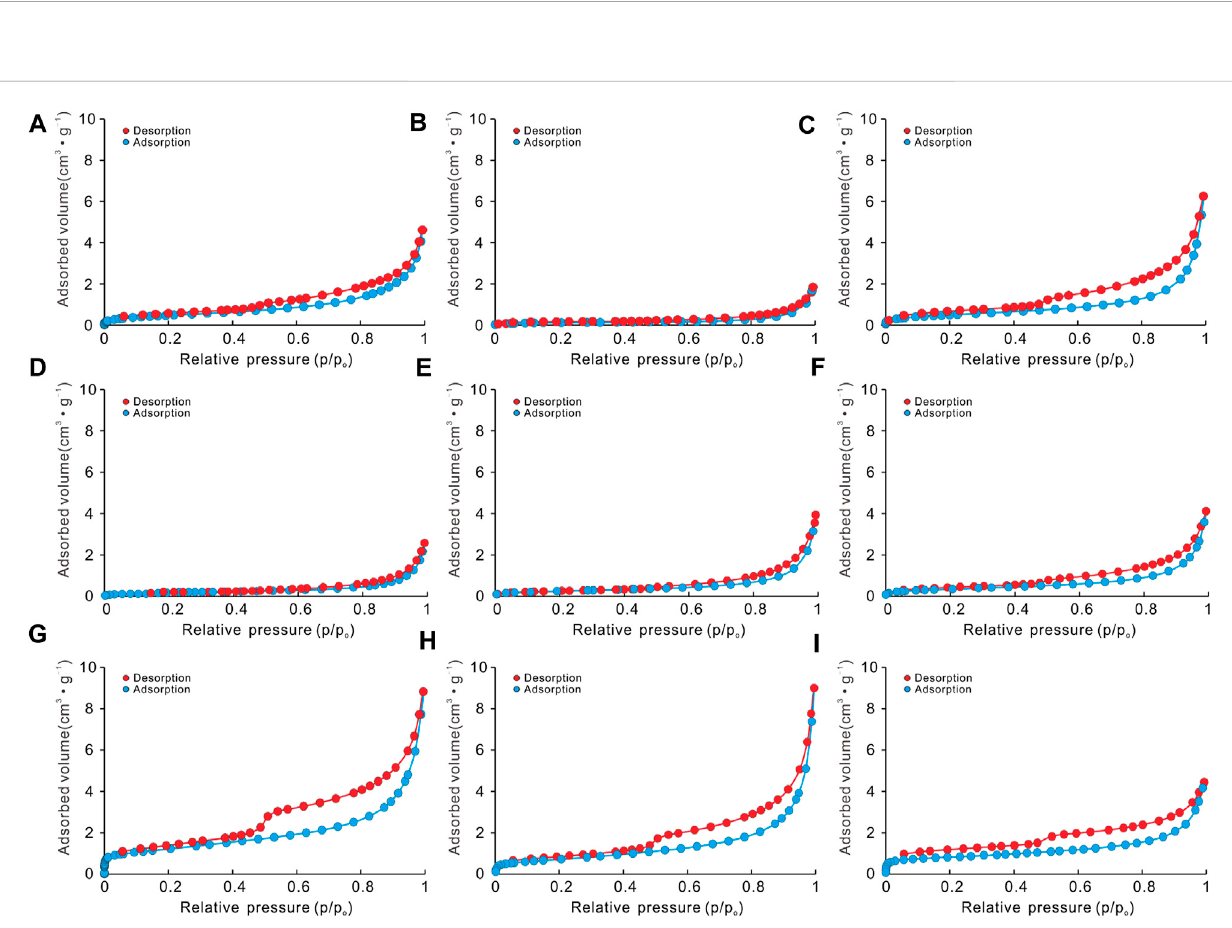
FIGURE 7 LTNA isotherms curves for the Lianggaoshan Formation lacustrine shale reservoir. (A) Type A shale, Well A, 2161.25 m; (B) Type A shale, Well B, 2455.06 m; (C) TypeAshale,WellC,1764.7 m; (D) TypeBshale,WellD,2437.33 m; (E) TypeBshale,WellB,2452.29 m; (F) TypeBshale,WellE,1751.71 m; (G) Type C shale, Well A, 2164.49 m; (H) Type C shale, Well C, 1928.58 m; (I) Type C shale, Well D, 2465.48